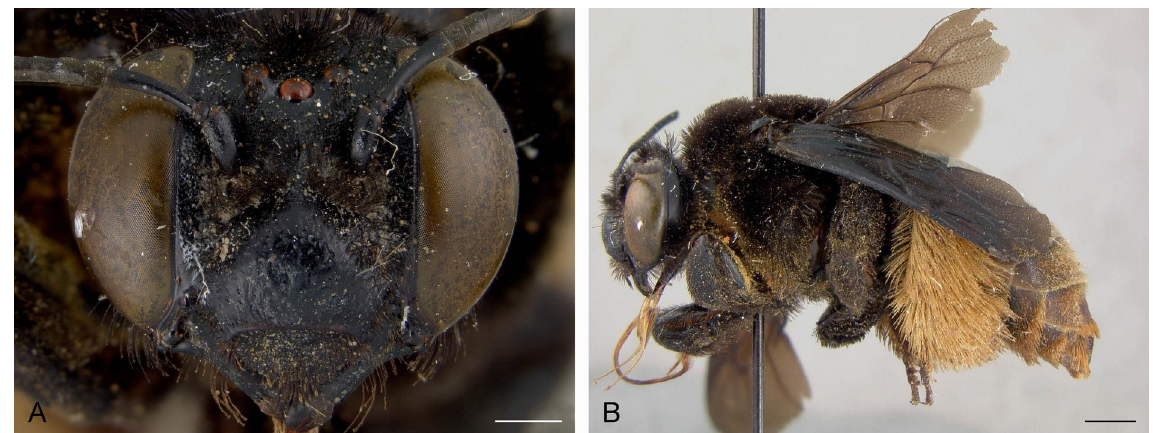
Fig. 21. Epicharis cisnerosi Cockerell, 1949, holotype, ♀ (NMNH; USNM ENT 00534191). A . Frontal view. B . Habitus, lateral view. Scale bars: A = 1 mm; B = 2